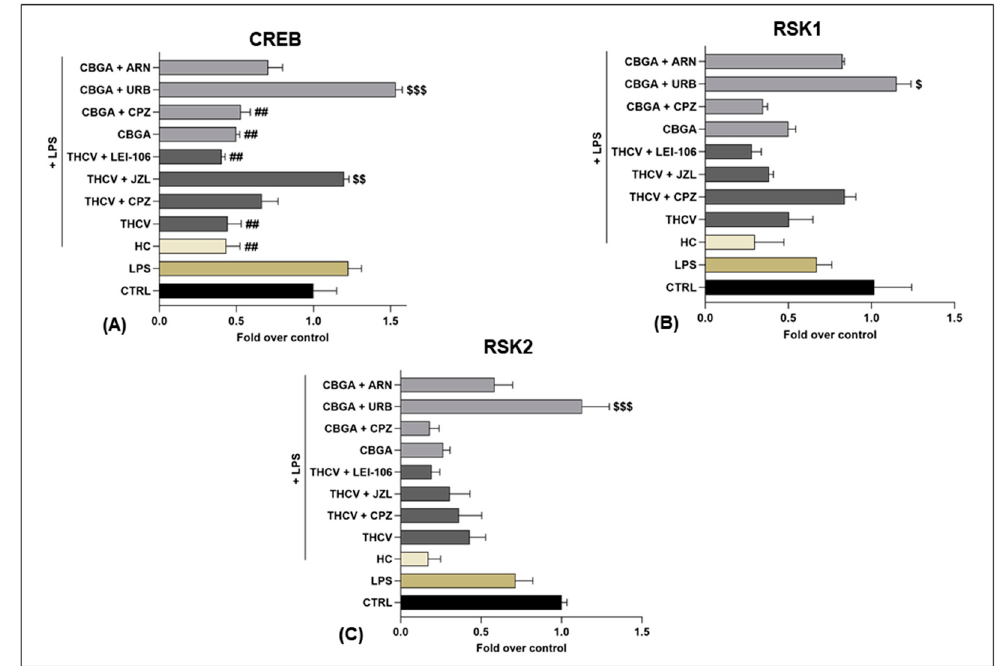
Figure 6. Expression of three of the phosphorylated proteins of the MAPK signaling pathway in HaCaT cells following 24 h treatment with LPS (5.0 μ g/mL) in the presence of pCBs (THCV (9.3 μ M) and CBGA (13.0 μ M)) and selected eCB system antagonists and inhibitors (CPZ (5.0 μ M), JZL184